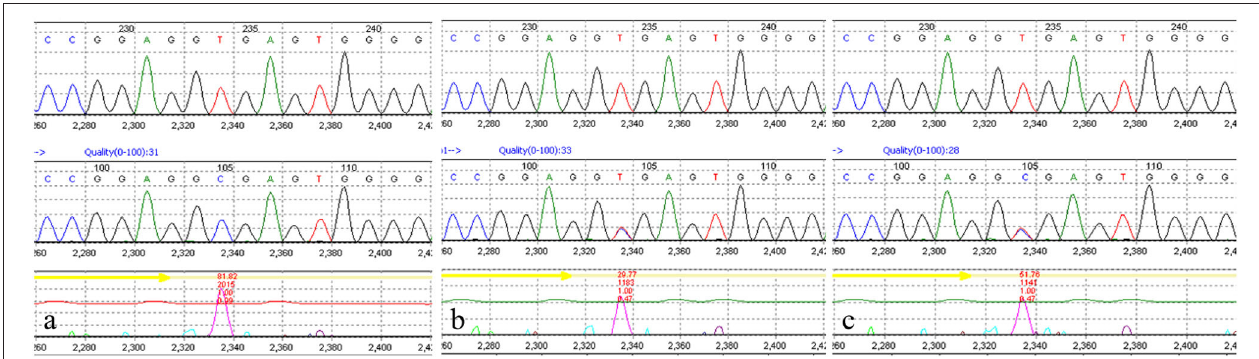
FIGURE 2 | Molecular study of the genomic DNA of patient 1 detected a novel AGK homozygous mutation (c.1131 + 2T > C) in the proband (a) . Both parents were confirmed to be heterozygous carriers (b,c) .